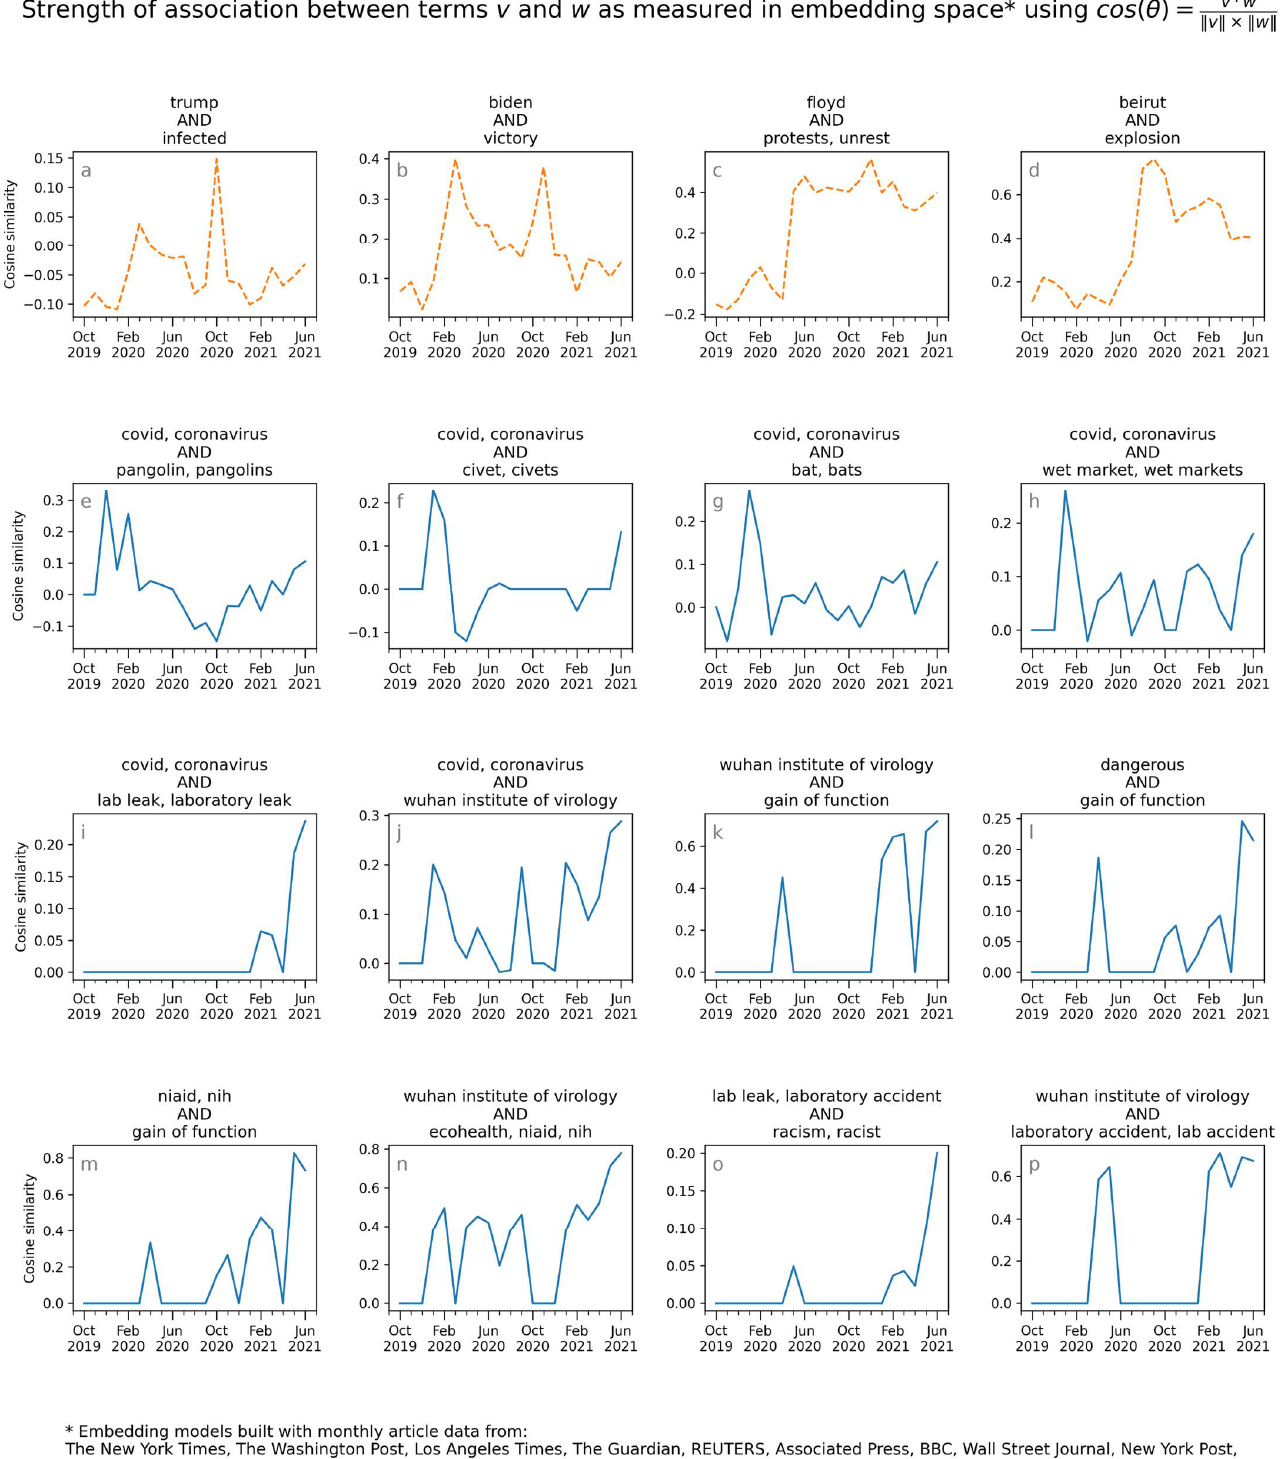
Figure 5. Chronological plots of monthly association strength between sets of terms in embedding models derived from news media content.